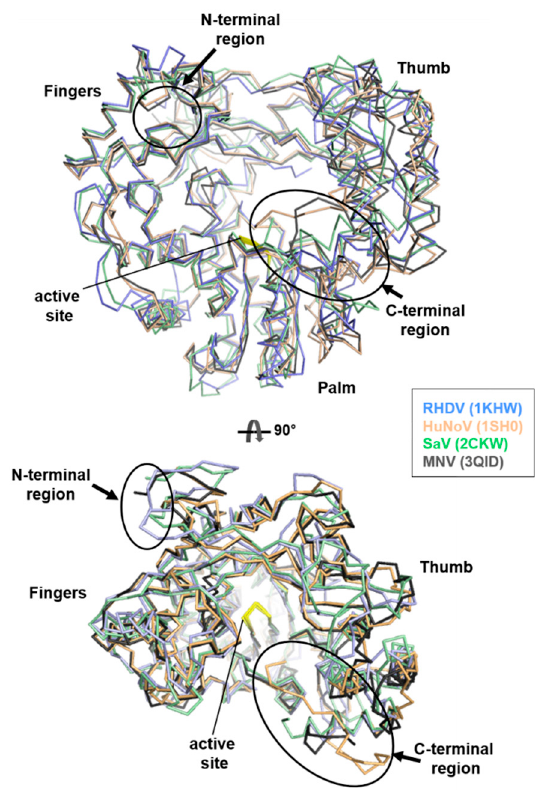
Figure 2. Superimposed structures of calicivirus RNA-dependent RNA polymerases (RdRps) based on 480 C α atoms. The crystal structures of the rabbit haemorrhagic disease virus (RHDV), human norovirus (HuNoV), sapovirus (SaV), and MNV RdRps are shown in a wireframe representation, coloured in sky blue, orange, green, and black, respectively. The active site and the N- and C-terminal regions are shown in yellow and in circles, respectively.